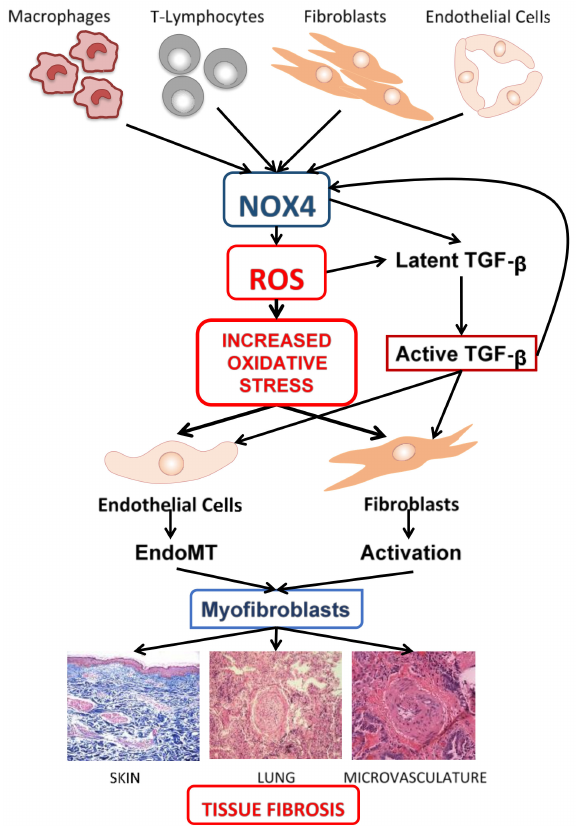
Figure 1. Schematic diagram depicting the mechanisms involved in the generation of increased oxidative stress and in the induction of SSc-associated tissue fibrosis. Numerous cell types relevant to SSc pathogenesis produce ROS and express NOX4. Stimulation of transcription of the NOX4 gene leads to increased NOX4 and elevated ROS production. These cells produce elevated ROS levels that are capable of inducing oxidative stress in various target cells as well as phenotypic changes in fibroblasts and endothelial cells, causing their conversion into activated myofibroblasts. Additionally, increased ROS production leads to release of TGF- β from the Latent TGF- β protein complex in the extracellular matrix, followed by its activation and activated TGF- β can then establish a paracrine pathway by causing further stimulation of NOX4 production. Activated TGF- β also directly stimulates the fibrotic process by inducing myofibroblast expansion through EndoMT and fibroblast activation. The activation of the ROS/NOX4 pathway leads to tissue fibrosis as illustrated in histopathological images of SSc skin, lung, and